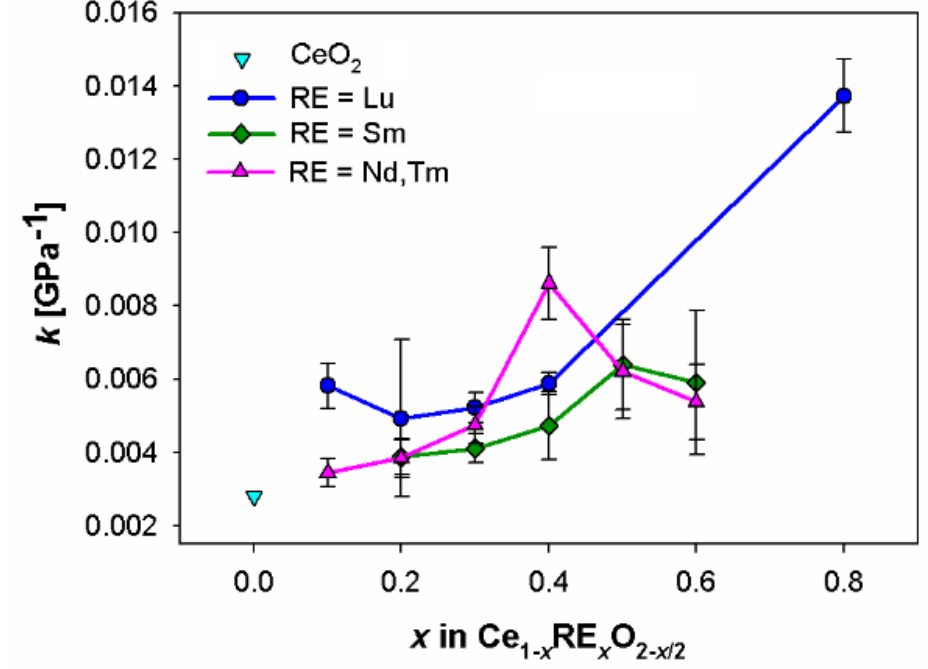
Figure 7. Compressibility 𝑘 as a function of the doping ion amount x for each studied system.